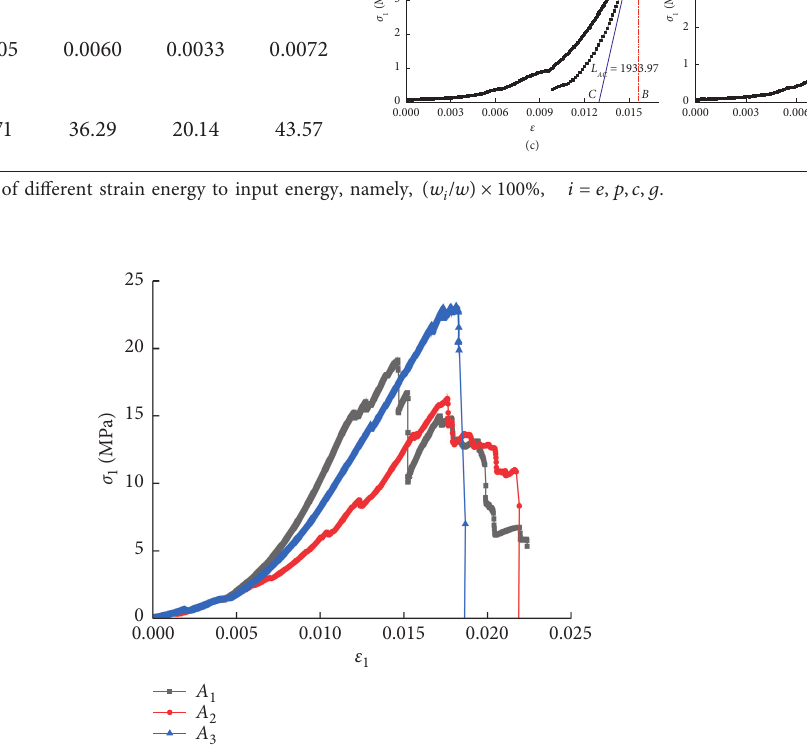
Figure 6: Stress-strain curves of coal samples from coal mine